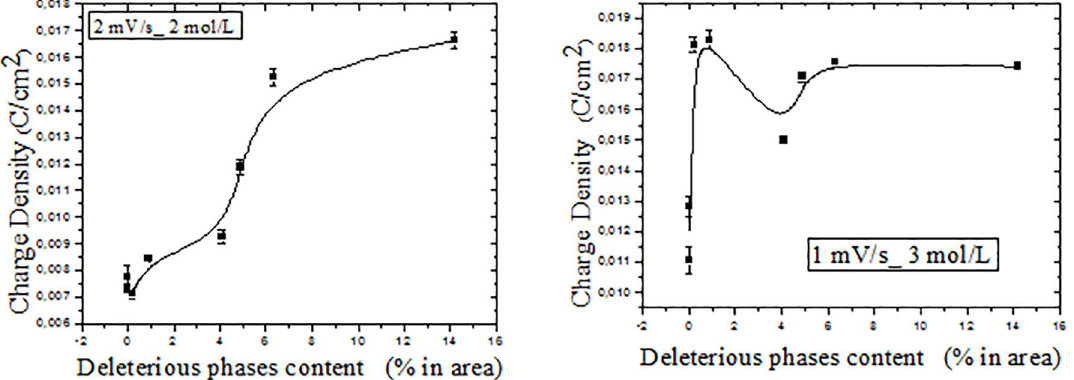
Figure 12. Density of charge in relation to the deleterious phase content of the samples obtained for conditions a) of 2 molar and 2 mV / s b) 3 molar and 1